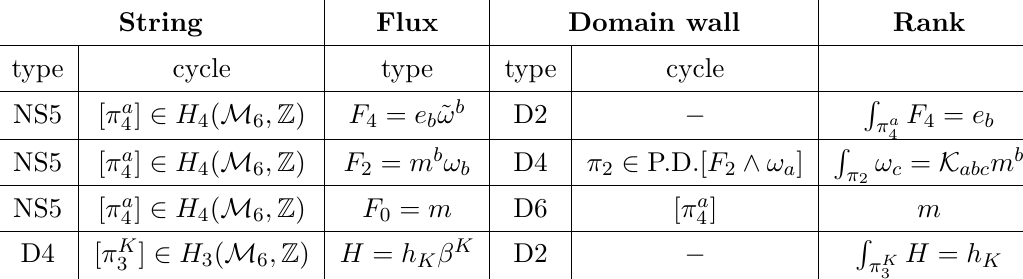
Table 1 . 4d strings that develop Freed-Witten anomalies in type IIA (cid:13)ux compacti(cid:12)cations, together with the (cid:13)uxes creating the anomaly and the domain walls curing it. The last column shows the amount of domain walls in terms of (cid:13)ux